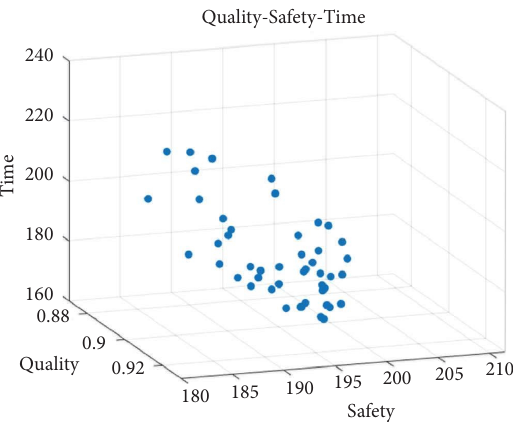
Figure 10: Time-cost-quality trade-of.